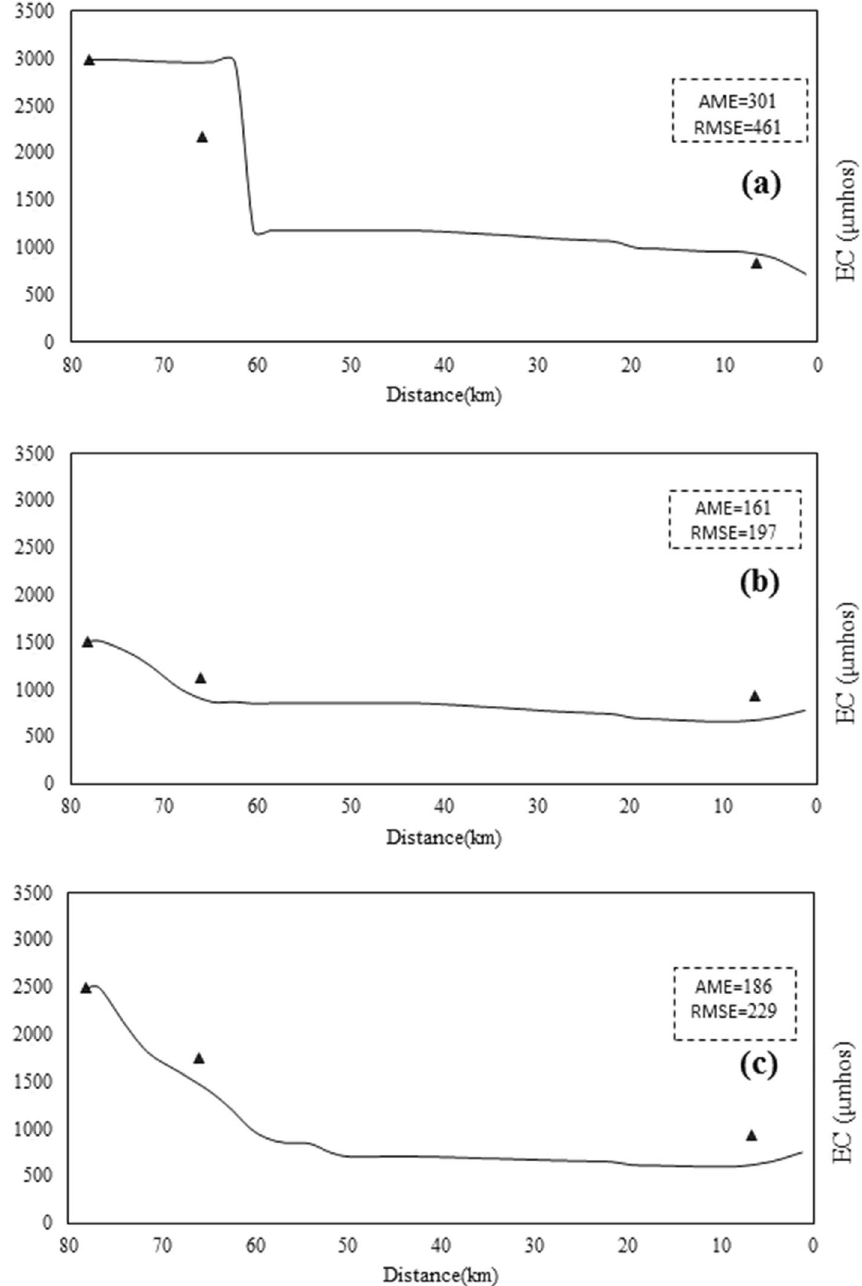
Figure 7. Total electric conductivity of Sarouq River in ( a ) spring, ( b ) autumn, ( c ) winter after